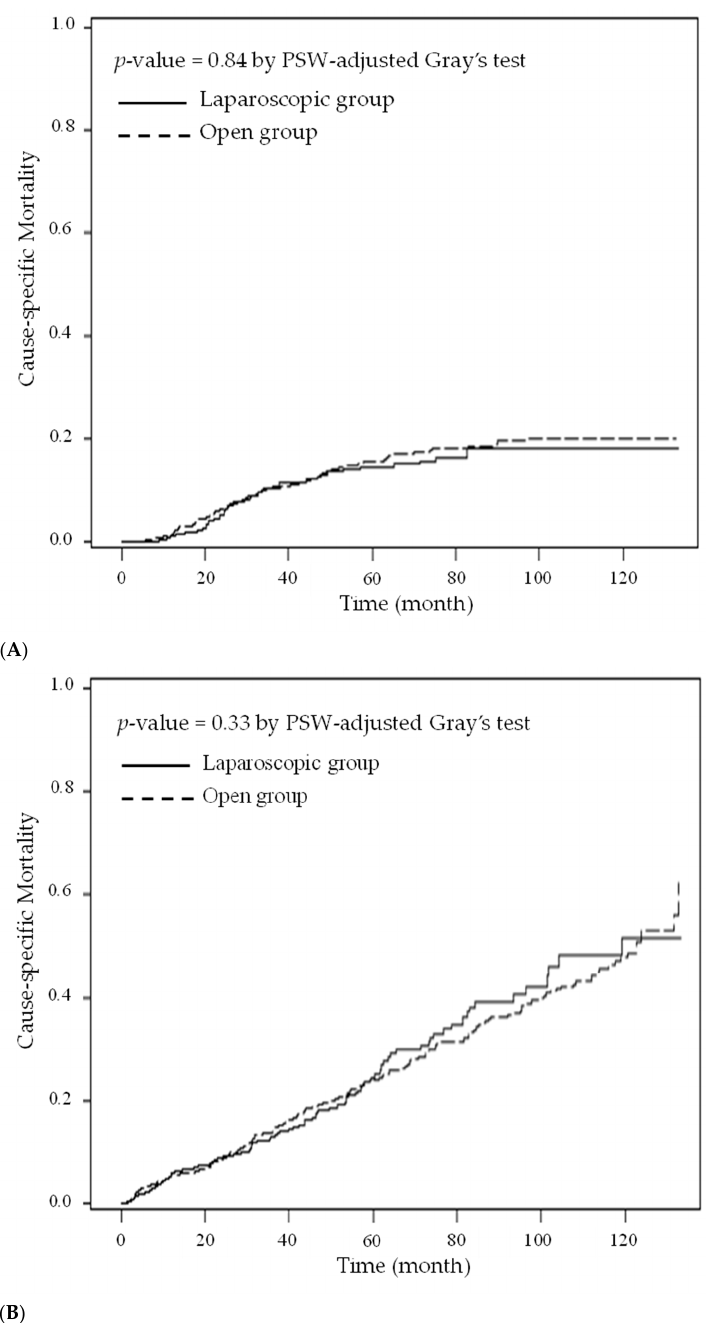
Figure 2. Overall survival and disease-free survival after propensity score weighting. ( A ). Disease- free survival; ( B ). Overall survival.